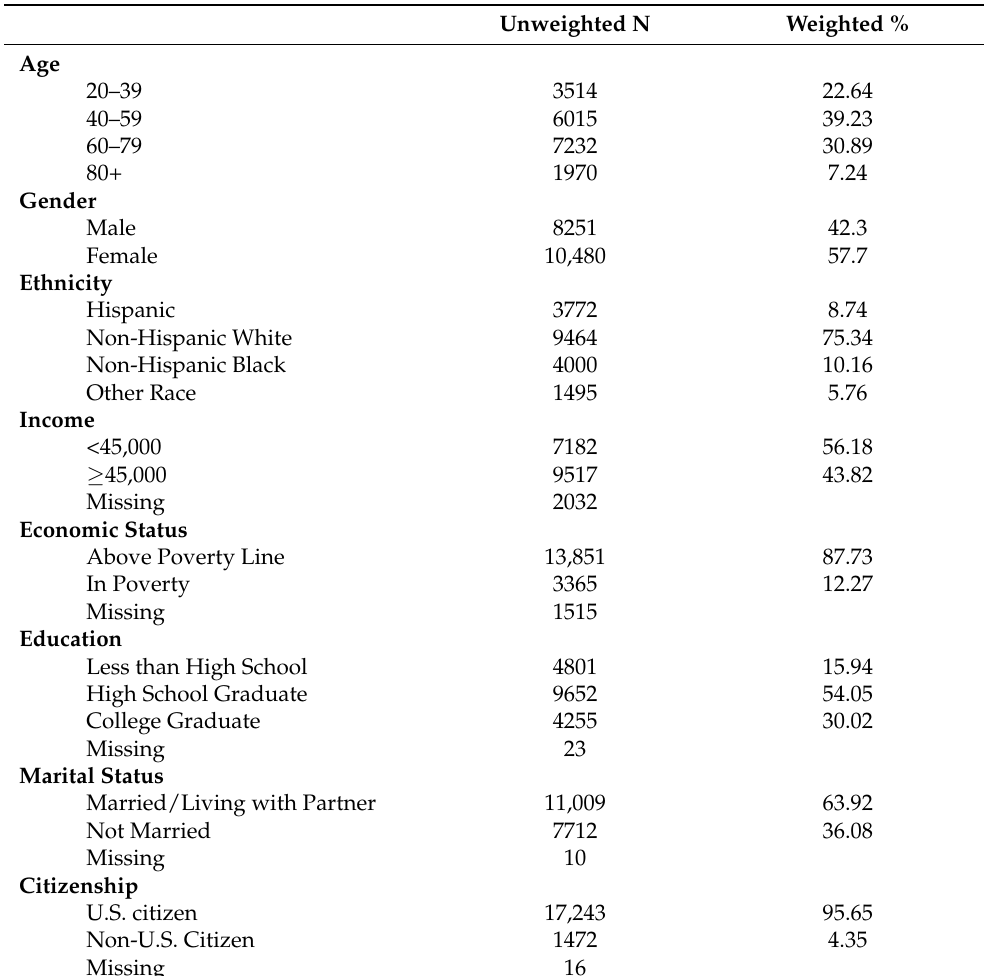
Table 1. Study Sample Demographic